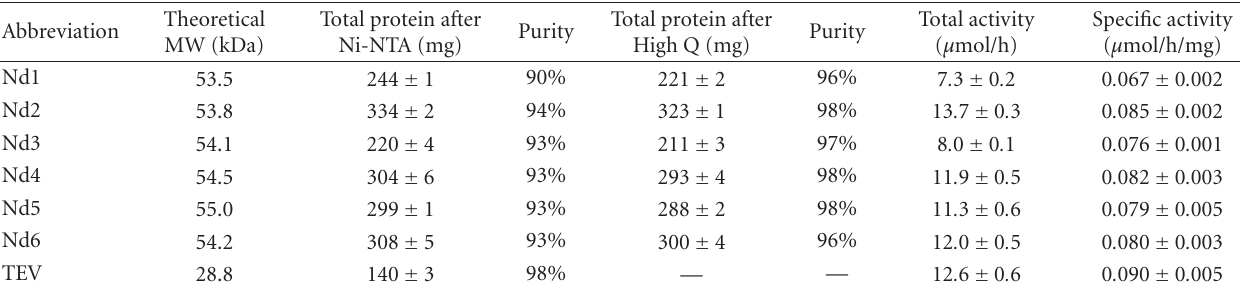
Figure 2: SDS-PAGE analysis of the expression and purification of sf GFP-TEV-His 6 Nd1–6 and TEV-His 6 . (a) Lanes 1–3 are the result for TEV-His 6 : Lane 1: autoinduced whole-bacterial lysate; Lane 2: flow through from Ni-NTA a ffi nity chromatography; Lane 3: the purified TEV- His 6 eluted from Ni-NTA a ffi nity chromatography. Lanes 4–7 are the result for sf GFP-TEV-His 6 Nd2: Lane 4: autoinduced whole-bacterial lysate; Lane 5: flow through from Ni-NTA a ffi nity chromatography; Lane 6: the purified sf GFP-TEV-His 6 Nd2 eluted from Ni-NTA a ffi nity chromatography; Lane 7: the pooled sample of purified sf GFP-TEV-His 6 Nd2 eluted from Q anion exchange chromatography. (b) The results for sf GFP-TEV-His 6 Nd1 and Nd3–6. “Ni” represents the results of the purified protein eluted from Ni-NTA a ffi nity chromatography; “Q” represents the pooled sample of purified protein eluted from Q anion exchange chromatography. “M” in (a) and (b) represents the protein marker. Table 3: Purification results of sf GFP-TEV-His 6 Nd1–6 and TEV-His 6 collected from 1-L of expression culture